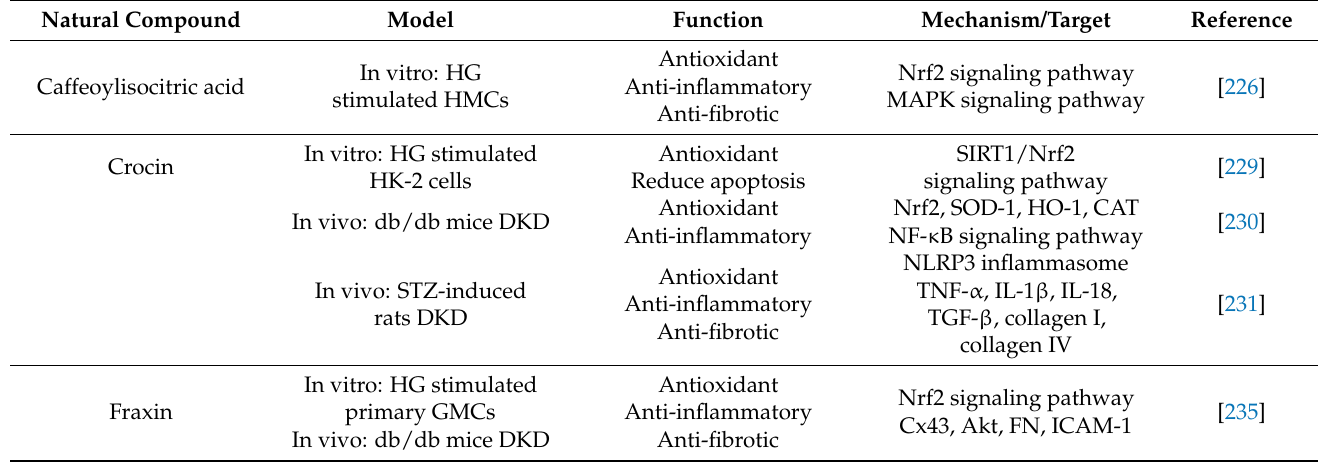
Table 6. Mechanisms of other compounds in the treatment of